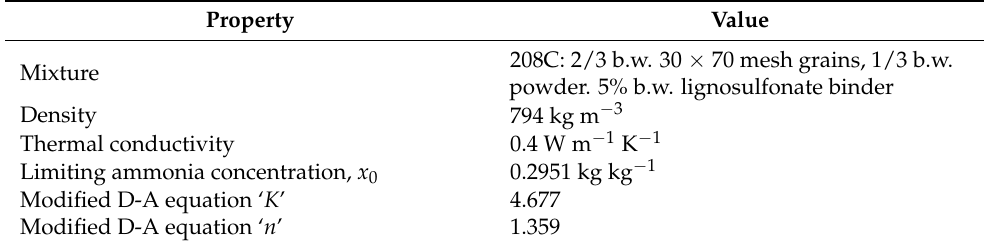
Table 2. Monolithic carbon properties.